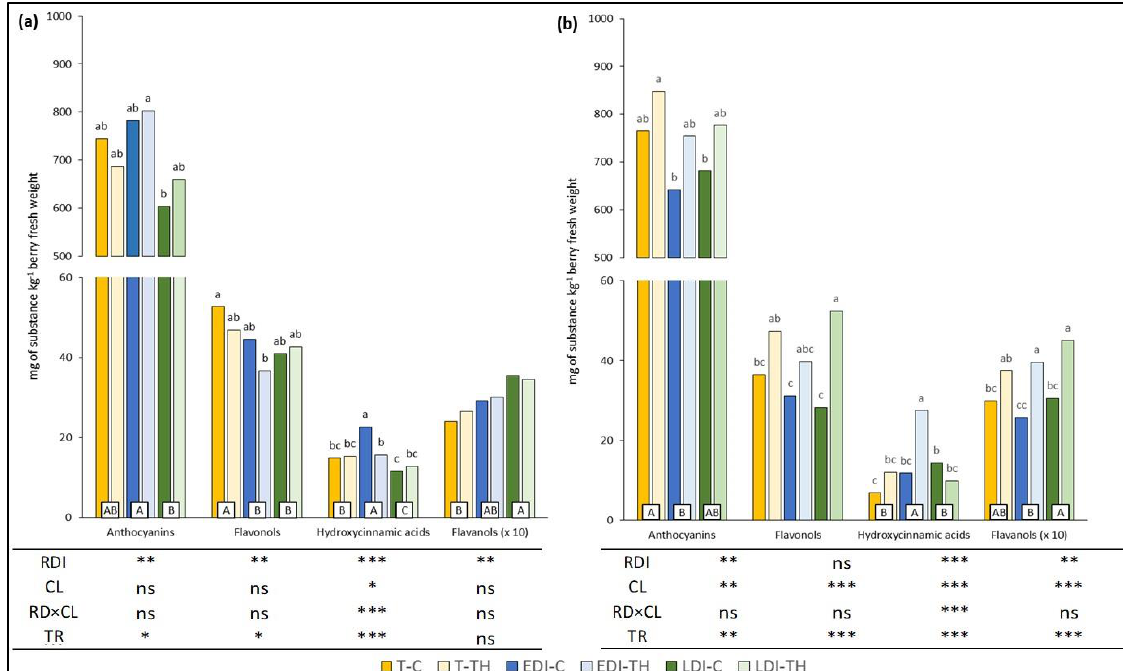
Figure 1. Effects of regulated deficit irrigation (RDI) and crop load level (CL) on total anthocyanins, flavonols, phenolic acids and flavanol content in 2009 ( a ) and 2010 ( b ). RDI, regulated deficit irrigation; CL, cluster loading level; TR, treatment. T, rainfed, EDI and LDI, regulated deficit irrigation in pre- and post-veraison, respectively. C, control; TH, cluster thinning. Different lower case letters are used to indicate significant differences for treatment factor and different capital letters for irrigation factor ( p < 0.05). *, **, *** and ns indicate significant differences at p < 0.05, p < 0.01, p < 0.001 and no significance, respectively.